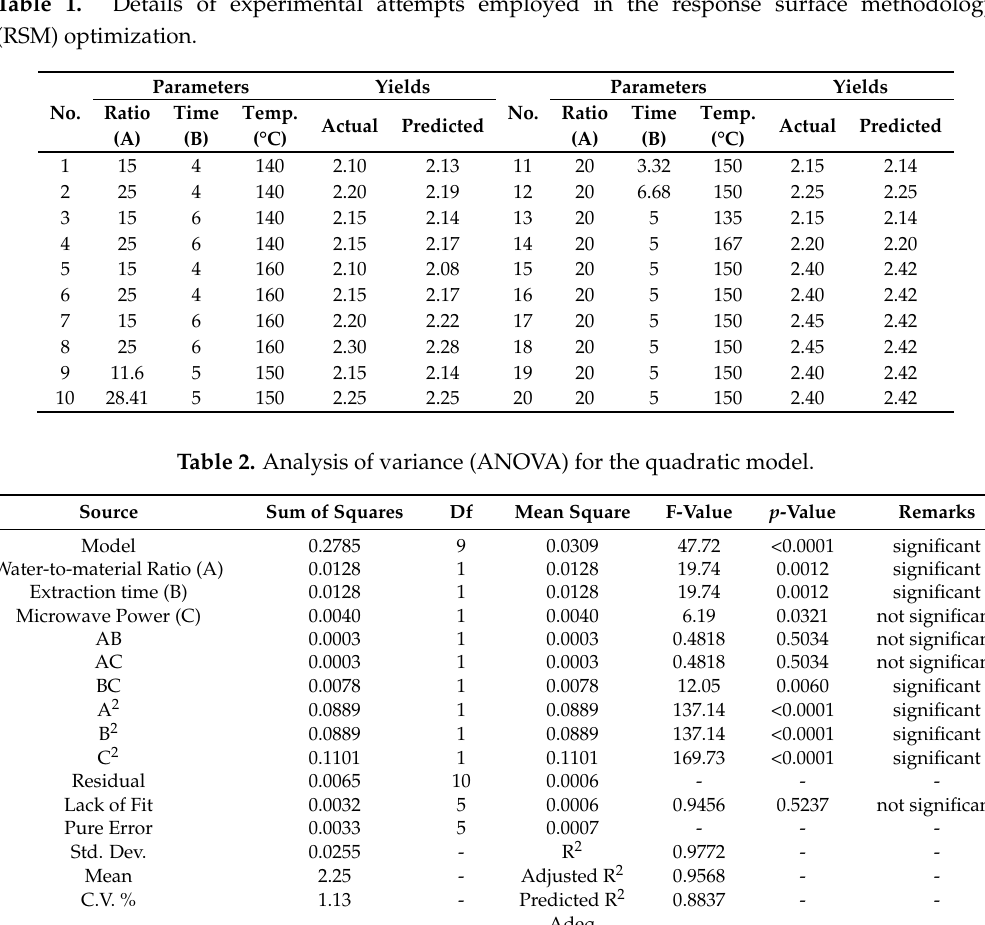
Figure 9. The influence of time extraction on the yield of essential oil.